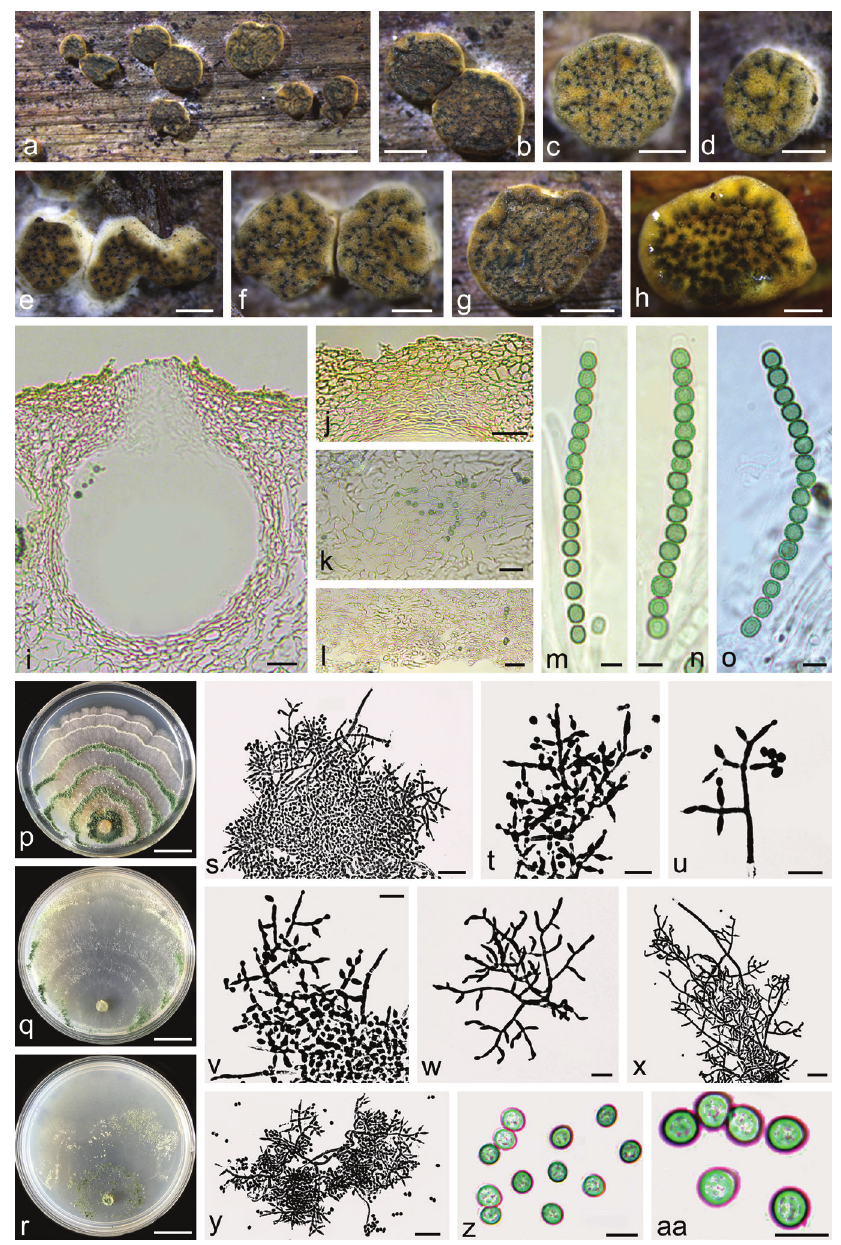
Figure 3. The new species Trichoderma zonatum , holotype (HMJAU 34820). a–o Sexual state. a–g Dry stromata on nature substrate h Mature stroma after rehydration i Perithecium in section j Cortical and subcortical tissue in section k Subperithecial tissue in section l Stroma base in section. m–o Ascus with part-ascospores. p–aa Asexual state. p–r Cultures after 7 d at 25 °C ( p PDA, q CMD, r SNA). s–y Conidiophores and phialides (SNA, 7 d). z, aa Conidia (SNA, 7 d). Scales bars: 2 mm ( a ); 1 mm ( b, g ); 500 μm ( c–f, h ); 20 μm ( i–l, s, x, y ); 5 μm ( m–o, z, aa ); 20 mm ( p–r ); 10 μm ( t–w